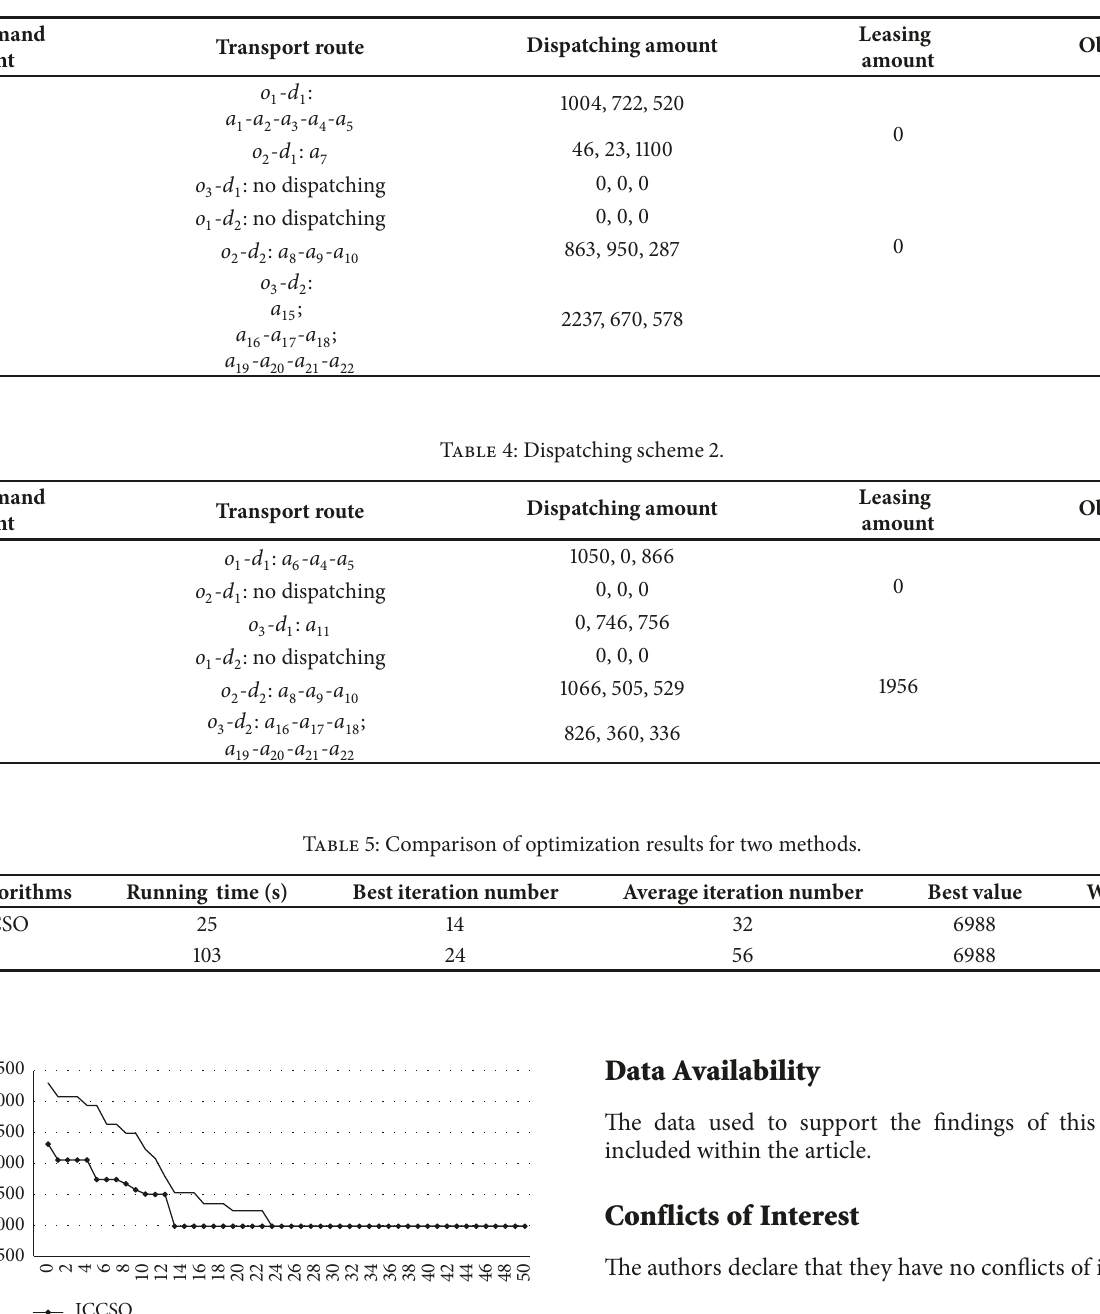
Table 3: Dispatching scheme 1.